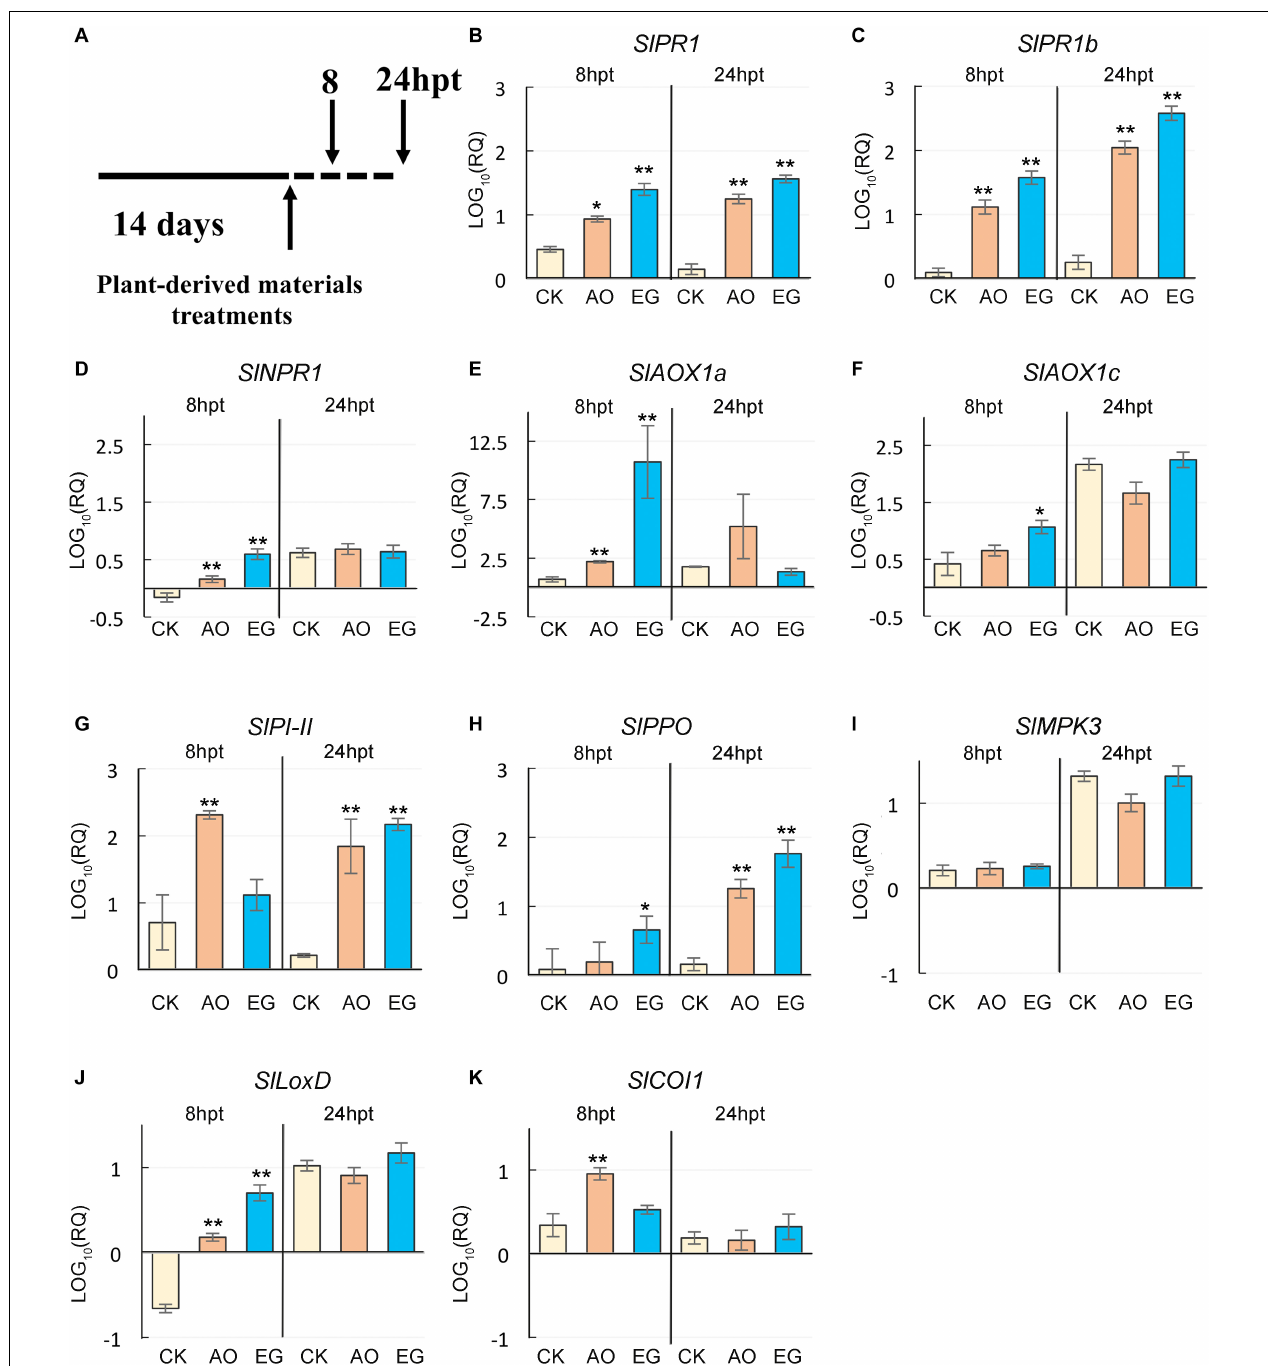
FIGURE 4 | Effects of anise oil and eugenol on the expression of SA- and JA-related genes in tomato plants. Fourteen-day-old tomato seedlings were treated with a control solution (CK), anise oil (AO), or eugenol (EG). Total RNA was extracted from these plants at 8 h post-treatment (hpt) and 24 hpt (A) . The expression levels of SA-related defense genes, SlPR1 (B) , SlPR1b (C) , SlNPR1 (D) , SlAOX1a (E) , and SlAOX1c (F) , and JA-related defense genes, SlPI-II (G) , SlPPO (H) , SlMAPK3 (I) , SlLoxD (J) , and SlCOI1 (K) , were analyzed by qRT-PCR. The β -actin expression level was used as the internal control. Relative gene expression levels were normalized against the expression level in untreated tomato plants. Data were analyzed with the 2 − (cid:49)(cid:49) Ct method. Bars represent the mean ( ± standard error of the mean) of three independent biological replicates each with three technical replicates. Significant differences between control and anise oil- or eugenol-treated plants were assessed with Student’s t -test ( ∗ P < 0.05; ∗∗ P < 0.01).